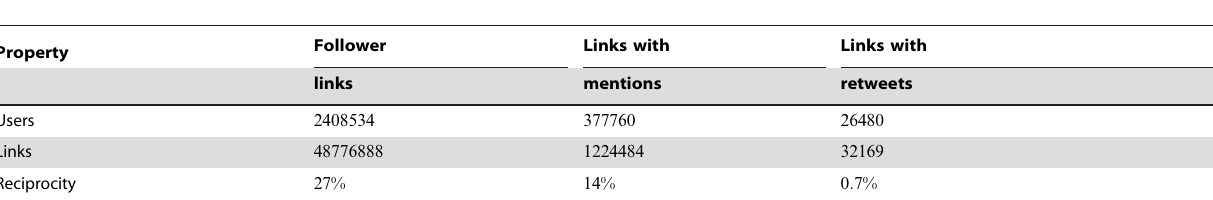
Table 1. Overall characteristics of the follower network and of the interactions taking place on it.